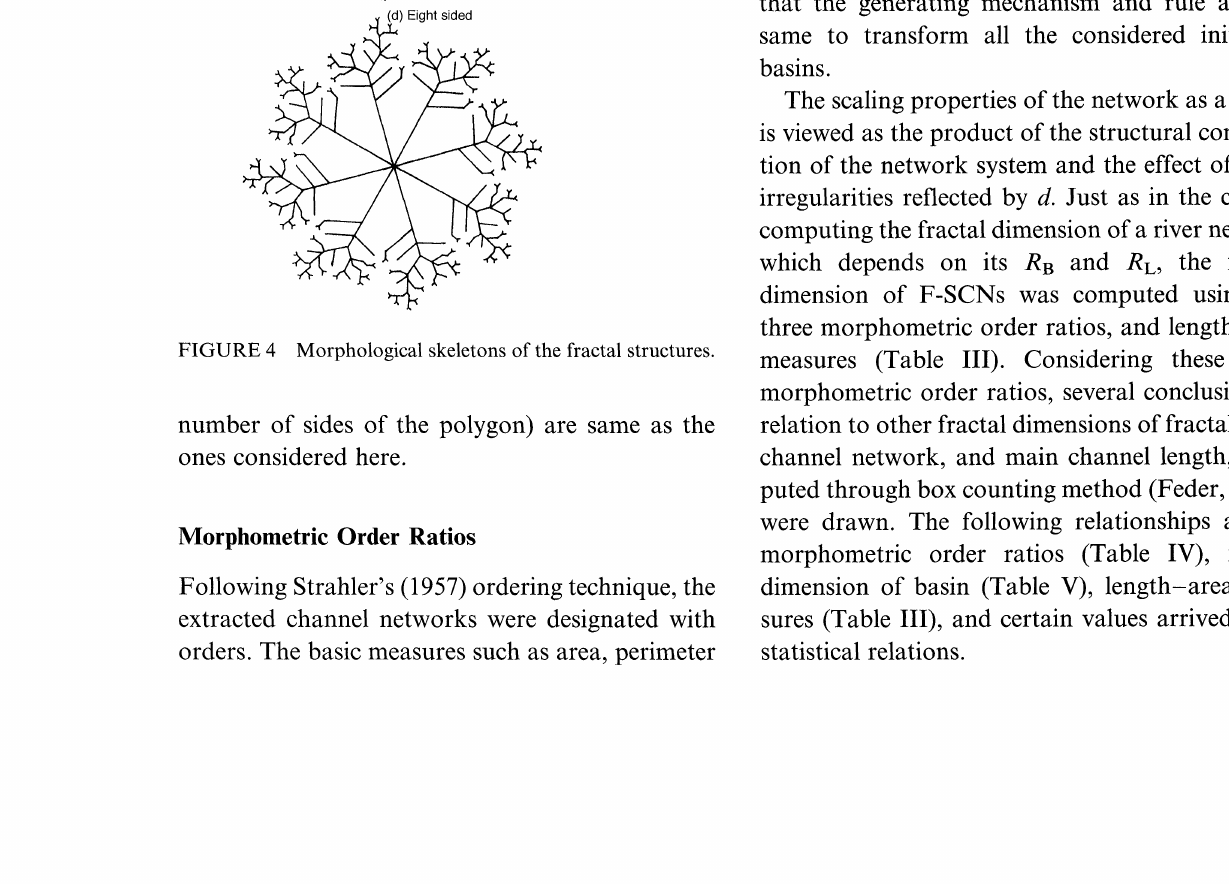
FIGURE 3 Generator.